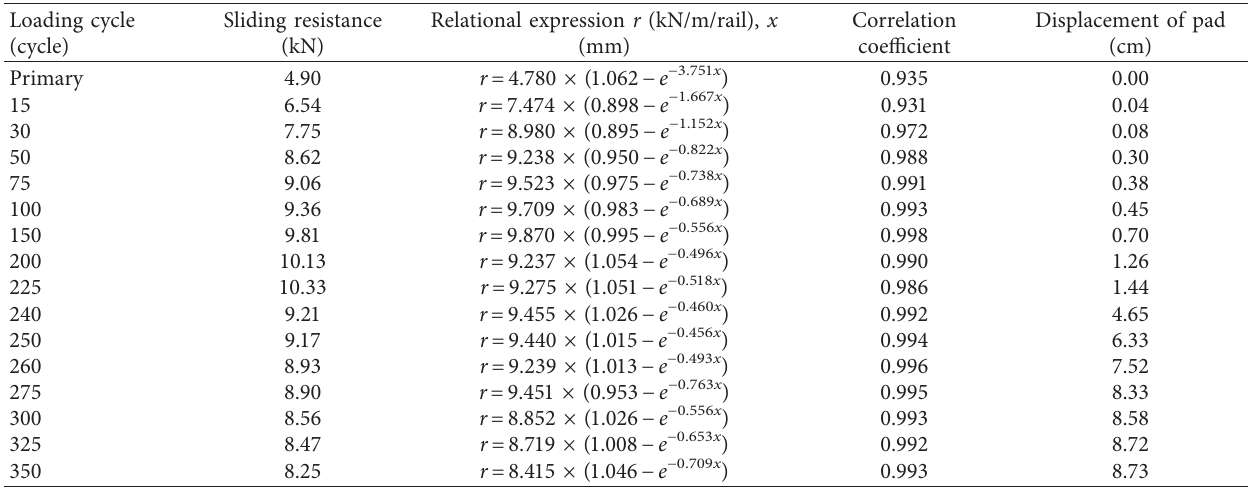
Table 1: The longitudinal resistance of the 0.5mm displacement point of the fastener under different reciprocating loading cycles. Loading cycles Primary 225 Longitudinal resistance (kN) Table 2: Relationship between longitudinal resistance ( r ) and displacement of fasteners ( x ) under different reciprocating loading times. Loading cycle Sliding (cycle)